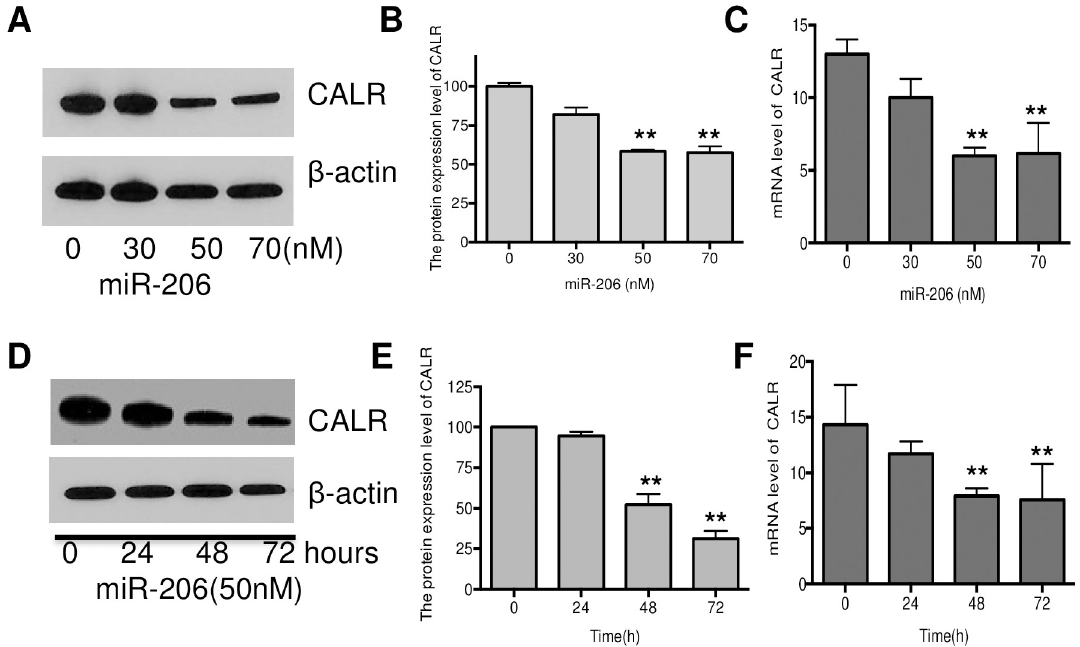
Fig 1. Effect of miR-206 on CALR expression in breast cancer stem cells. Human breast cancer stem cells were treated with various concentrations of miR-206 mimics (0, 30, 50, 70 nM) for 48 h. CALR protein expression (A&B) and mRNA expression (C) level were measured by Western blot and real-time quantitative PCR, respectively; Human breast cancer stem cells were treated with 50 nM miR- 206 mimics for 0, 24, 48 and 72h. CALR protein expression (D&E) and mRNA expression level were determined by Western blot and real-time quantitative PCR, respectively. All results are expressed as the mean ± S.D. from three independent experiments. � P < 0 . 05 , �� P < 0 . 01 vs. control group.